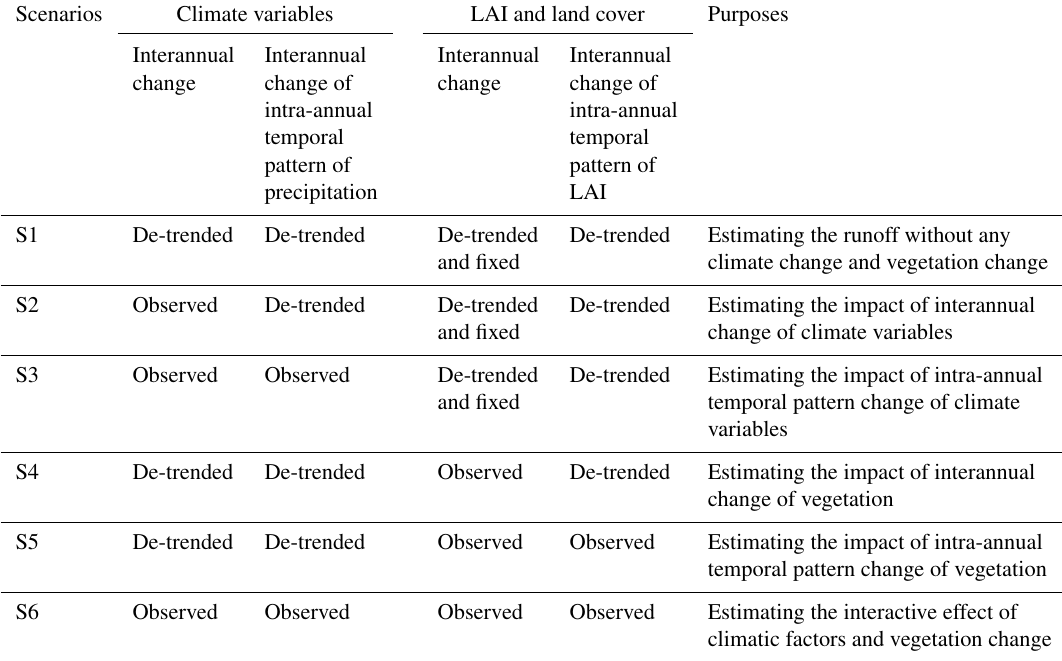
Table 2. Scenario simulation experimental design to attribute the effects of climate change and vegetation change on the runoff trend. Scenarios Climate variables LAI and land cover Purposes Interannual Interannual Interannual Interannual change change of change change of intra-annual intra-annual temporal temporal pattern of pattern of precipitation LAI S1 De-trended De-trended De-trended De-trended Estimating the runoff without any and fixed climate change and vegetation change S2 Observed De-trended De-trended De-trended Estimating the impact of interannual and fixed change of climate variables Observed Observed De-trended De-trended Estimating the impact of intra-annual and fixed temporal pattern change of climate variables Observed De-trended Estimating the impact of interannual change of